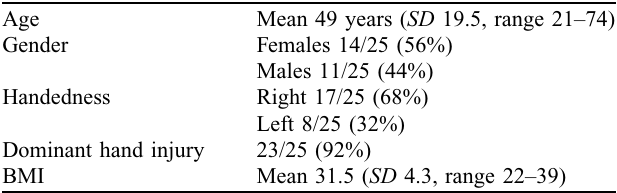
Table 2. Patient demographics in volar locking plate